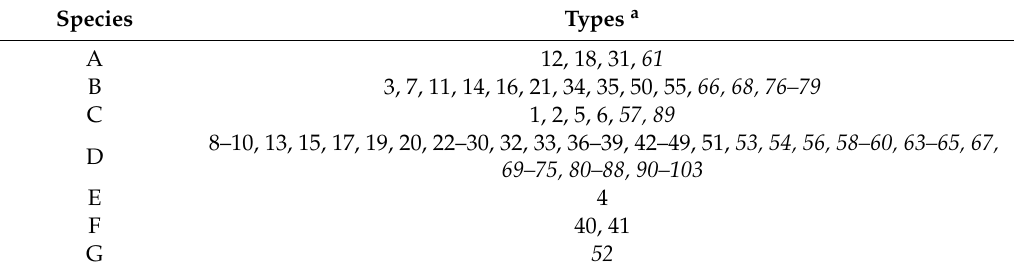
Table 1. Current taxonomy of human